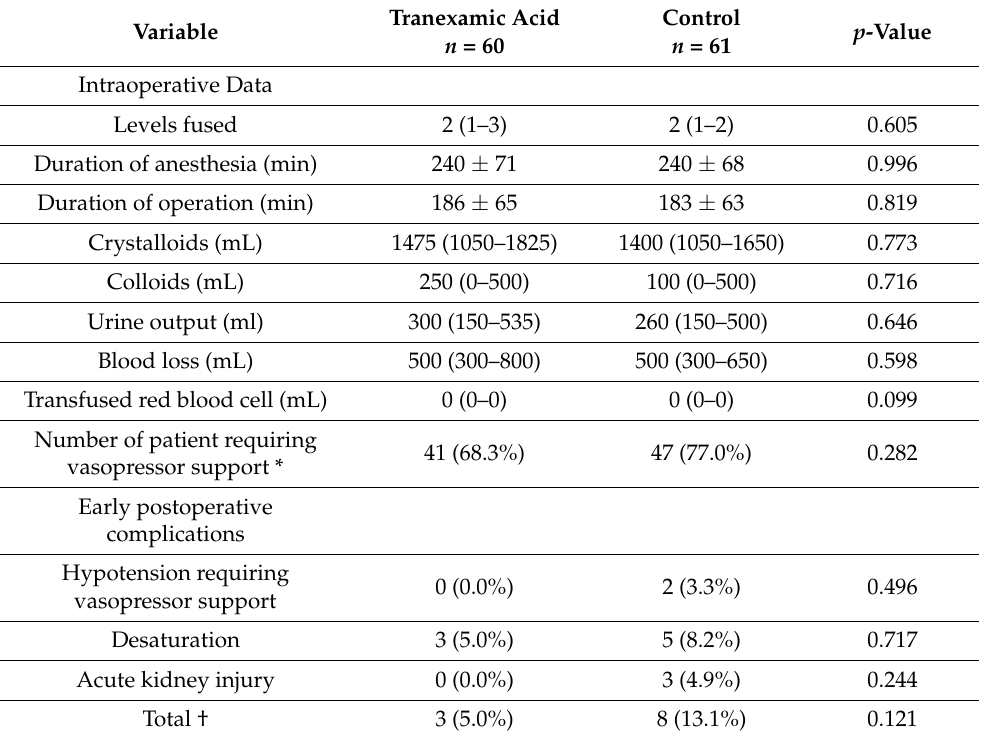
Table 2. Intraoperative data and early postoperative